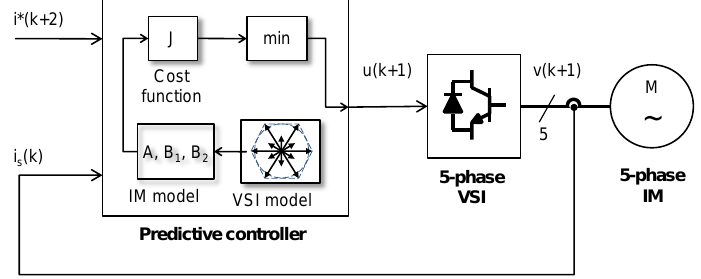
Figure 1. Diagram of predictive stator current control of a five-phase IM fed by a